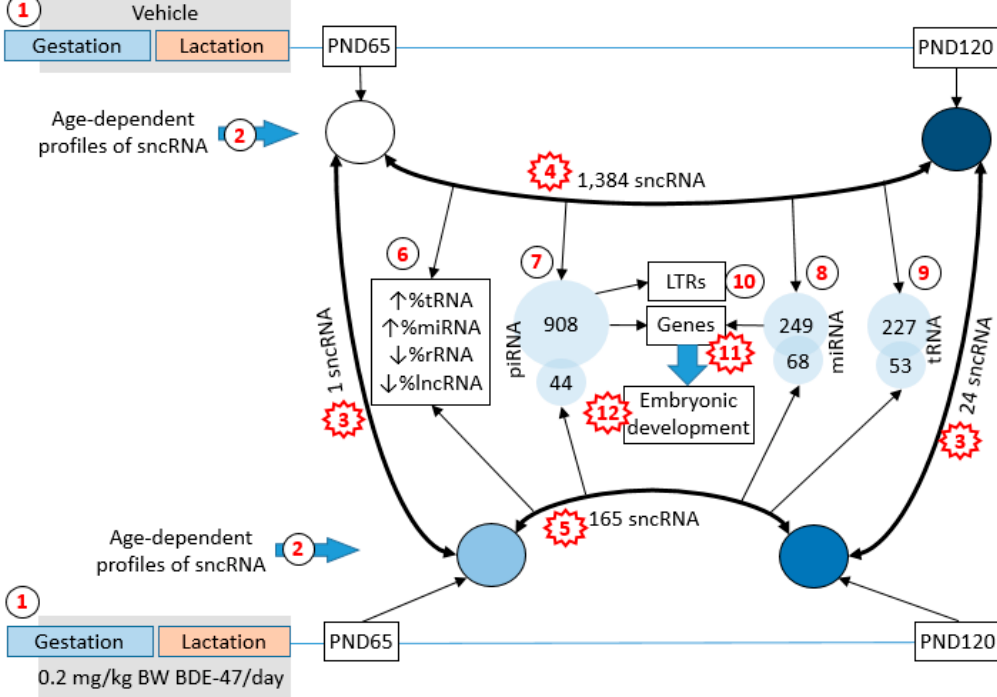
Figure 1. Summary of the study design and main findings. Sperm samples were collected on postnatal day (PND)65 and PND120 from rats perinatally exposed to 2,2 ′ ,4,4 ′ -tetrabromodiphenyl ether (BDE-47) or vehicle (1). Profiles of small non-coding RNA (sncRNA) were analyzed in these samples (2). A comparison of sncRNA profiles from exposed and control animals of the same age showed only minor effects of exposure (3). Profiles of sncRNA in control animals of different ages had drastic differences (4). Age-dependent differences were attenuated in exposed animals (5) due to the “convergence” of sncRNA profiles (shown by shades, where the profile of young controls is shown in white, while profile of mature controls is dark blue, and the profiles of both age groups of exposed rats have intermediate shades). Fraction distributions of sncRNA subtypes undergo similar age-dependent changes (shown by arrows) in both exposure groups (6). Age-dependent piRNA (7), miRNA (8) and tRNA (9) were identified for control and exposed animals. Targets of piRNA were enriched for long